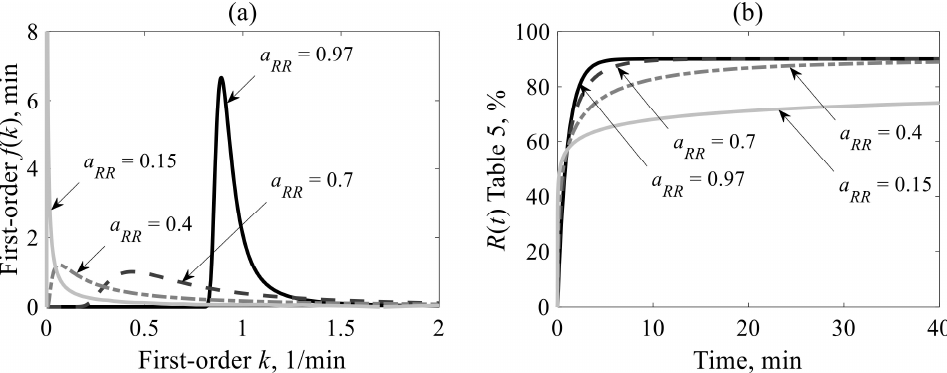
Figure 5. ( a ) Equivalent first-order f ( k )s from the Rosin-Rammler model. ( b ) Time-recovery curves, Table 5.